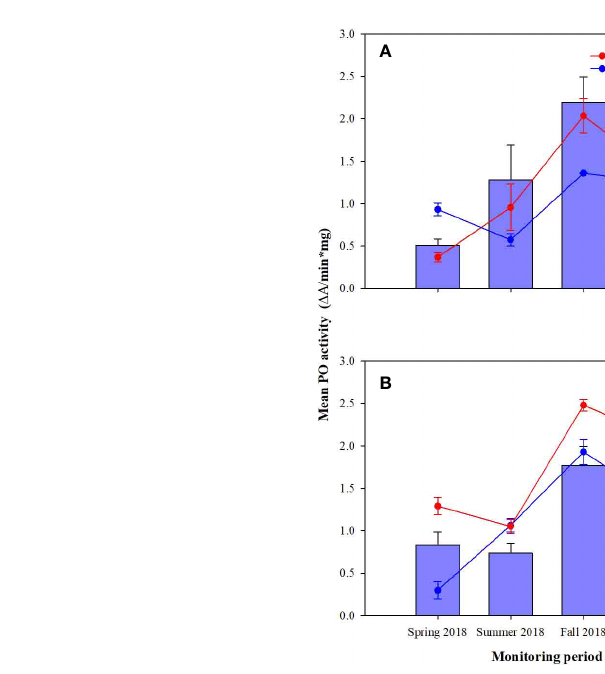
FIGURE 3 Comparison of Phenoloxidase (PO) activity over time and between, (A) Control colonies from deep farms (DD) and (B) control colonies from shallow farms. Red and blue circles represent water temperature and light intensity. Whiskers represent standard